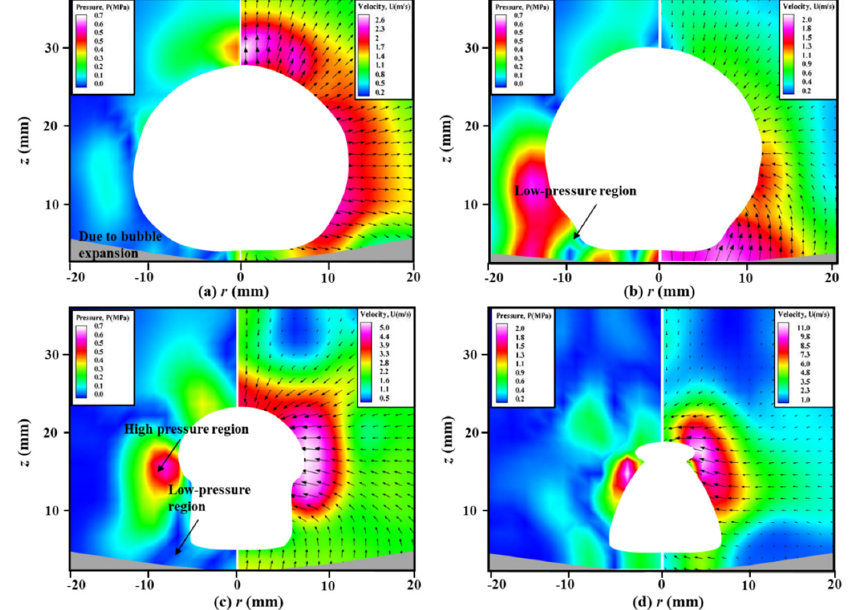
Figure 6. The measured velocity fields (right) and calculated pressure contours (left) around a bubble near the elastic boundary for γ = 0.81 and R m = 19.4 mm at typical time of ( a ) t = 0.88 ms, ( b ) t = 2.92 ms, ( c ) t = 3.68 ms and ( d ) t = 3.88